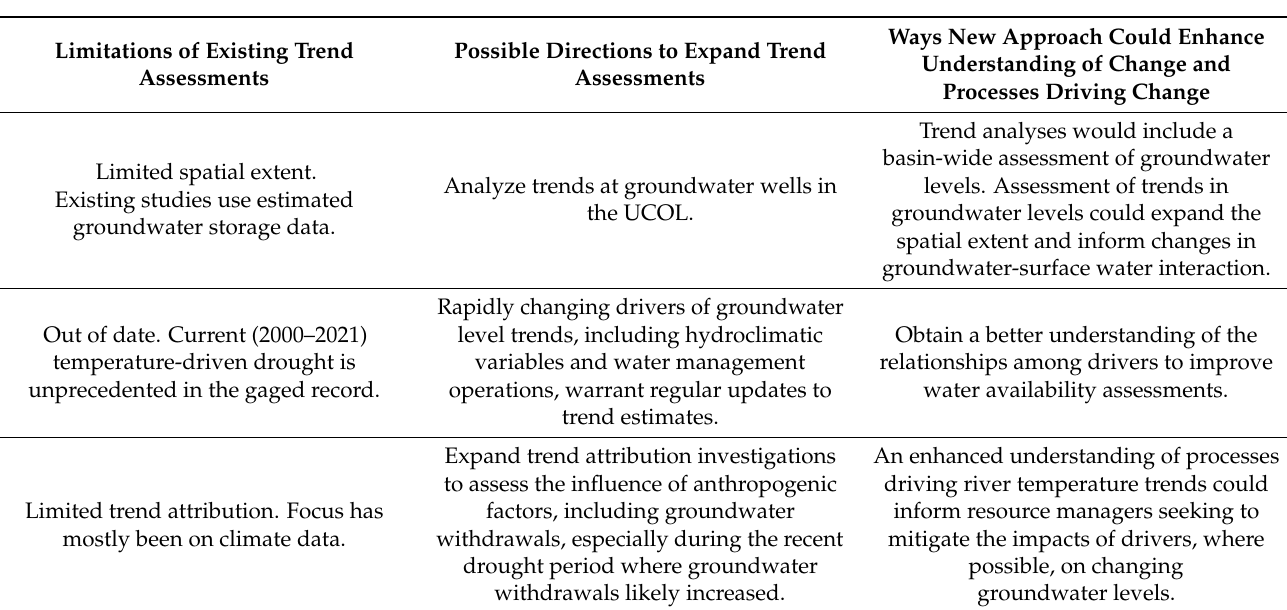
Table 4. Limitations of existing groundwater quantity trend assessments and opportunities to enhance